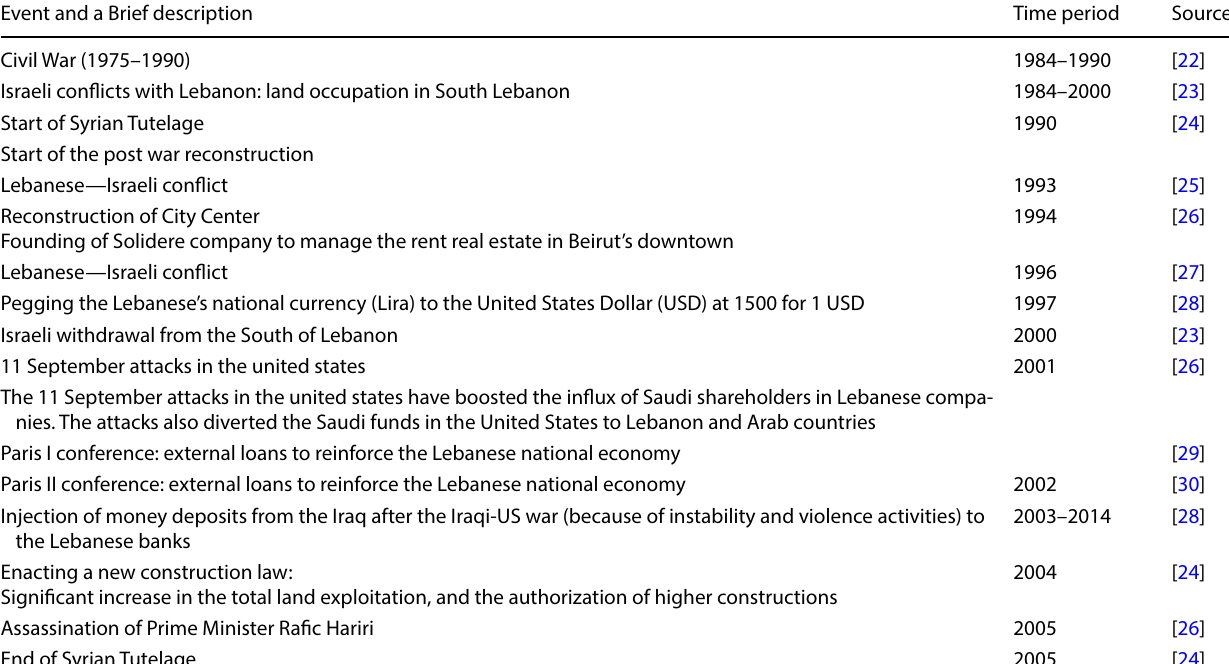
Table 1 Political, financial, external and internal security events after year